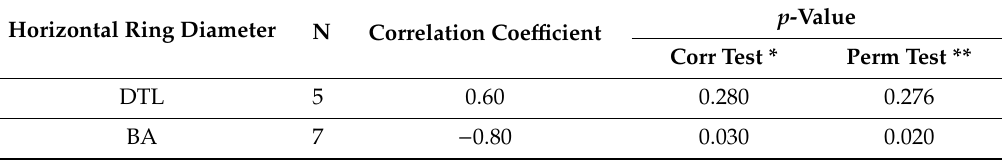
Table 7. Correlations between progression of 30 Hz flicker amplitude versus progression of horizontal ring diameter.